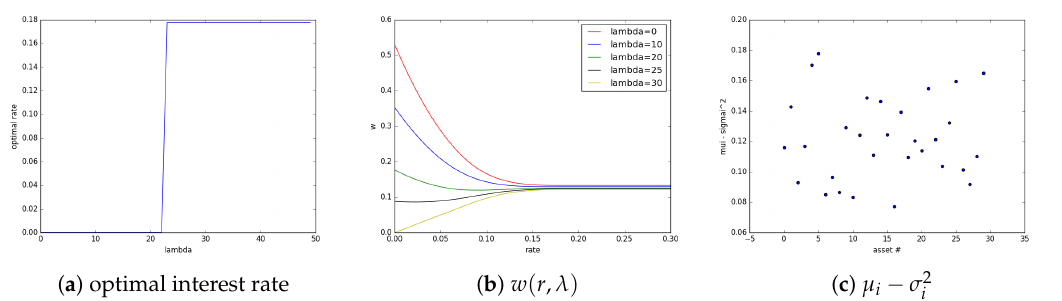
Figure 10. Optimal interest rate with N = 30 uncorrelated assets. with mean and standard deviation µ i , σ i , i = 1, . . . , N i.i.d uniform on [ 0.1,0.2 ]